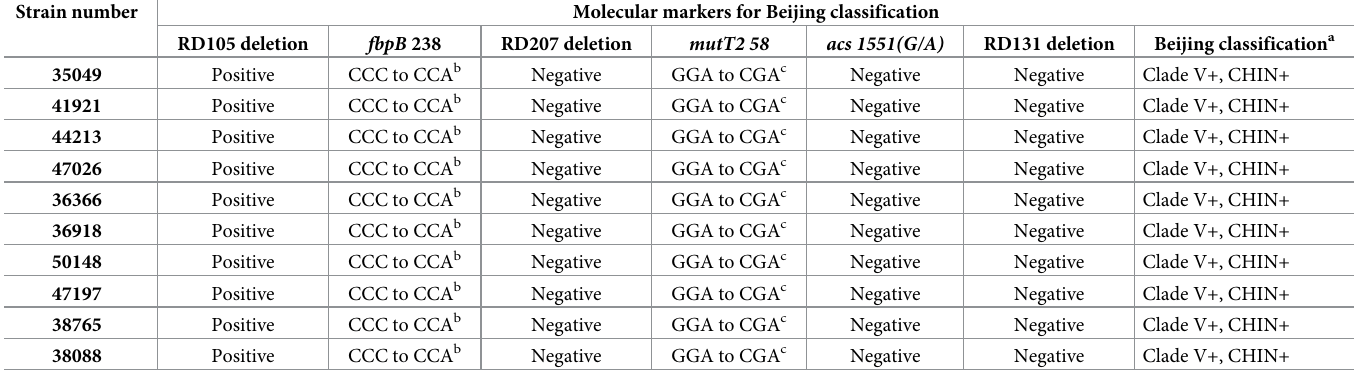
Table 2. Results of molecular markers for Beijing classification.